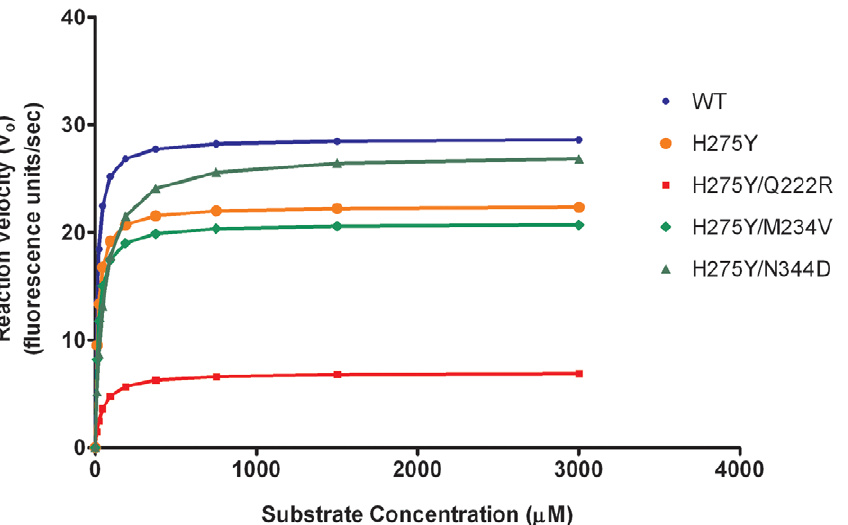
Figure 1. Neuraminidase (NA) enzyme kinetics of recombinant A/Brisbane/59/2007-like (H1N1) viruses. The rate of substrate conversion velocity (V 0 ) by NA enzymes from a standardized dose of 10 6 PFU/ml of recombinant virus was determined. The fluorogenic substrate (MUNANA) was used at final concentrations of 0 to 3000 m M. Fluorescence was measured every 90 sec for 53 min at 37 u C using excitation and emission wavelengths of 355 and 460 nm, respectively. The data of one representative experiment performed in triplicate is shown.